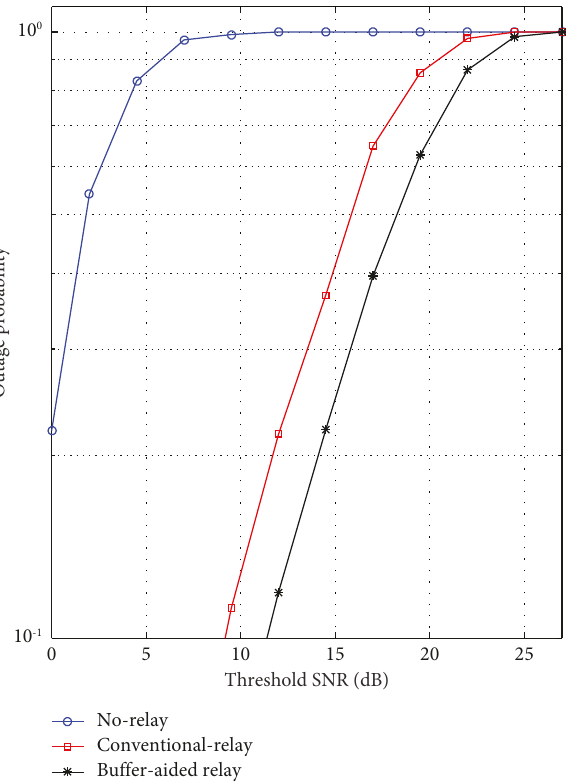
Figure 3: Throughput comparison between the available solutions and the proposed